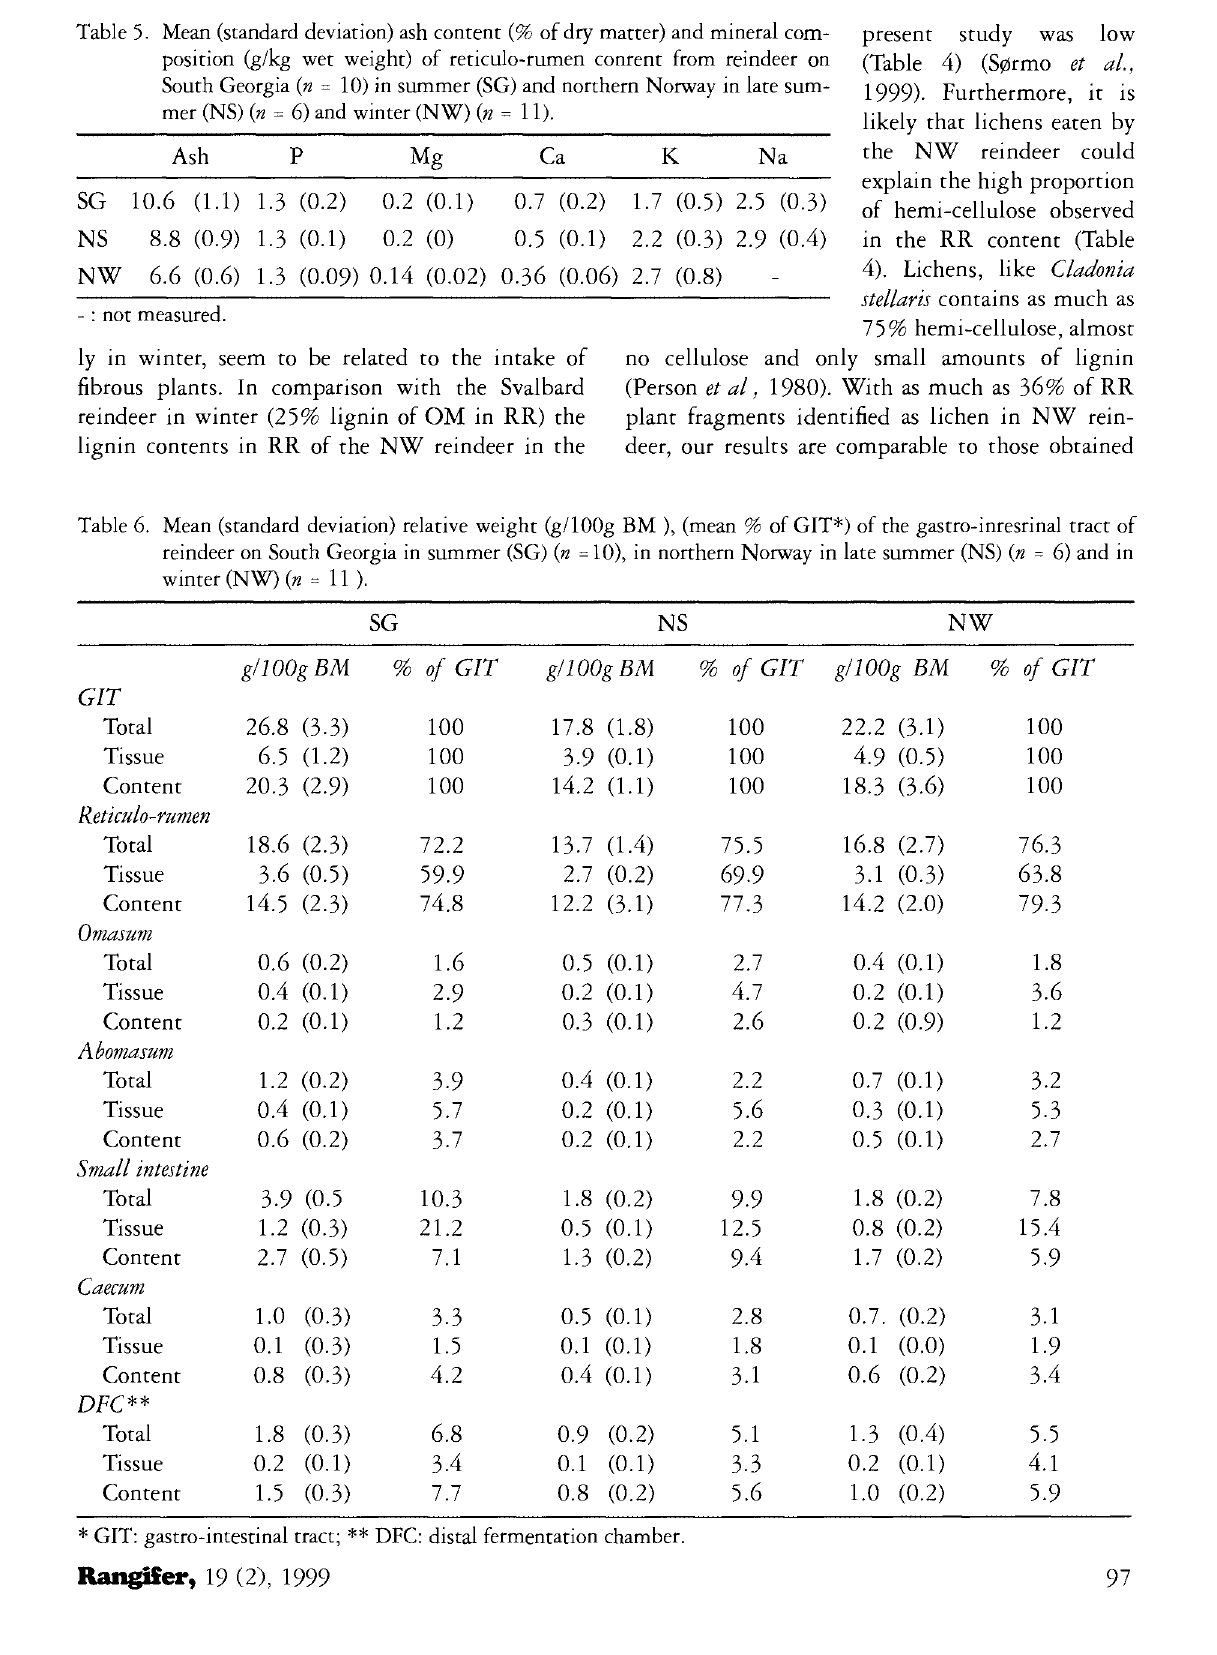
Table 5. Mean (standard deviation) ash content (% of dry matter) and mineral com position (g/kg wet weight) of reticulo-rumen conrent from reindeer on South Georgia (» = 10) in summer (SG) and northern Norway in late sum mer (NS) (» = 6) and winter (NW) (n = 11).